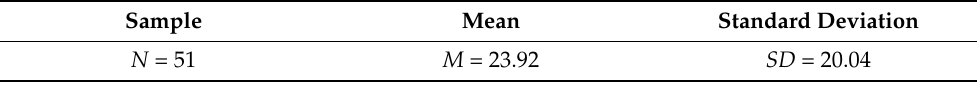
Table 1. Study Sample